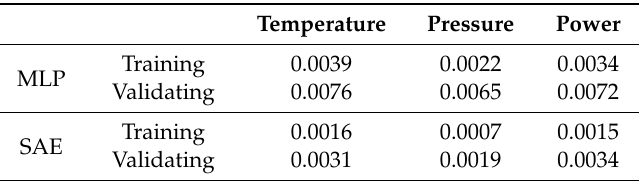
Table 2. The root mean square errors of three adopted models.